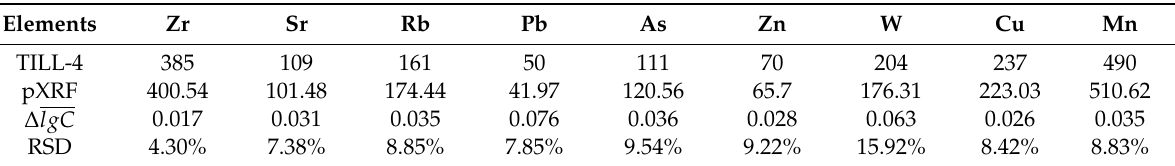
Table 1. Accuracy and precision of the pXRF.